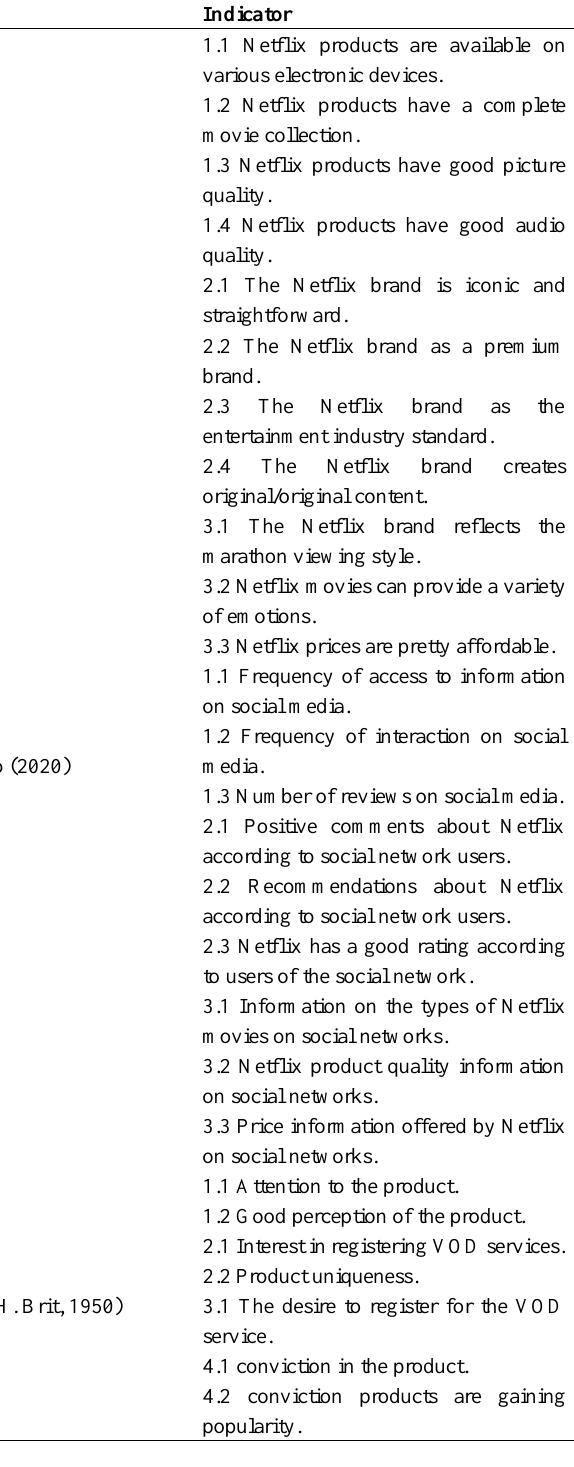
Table 1: Operational